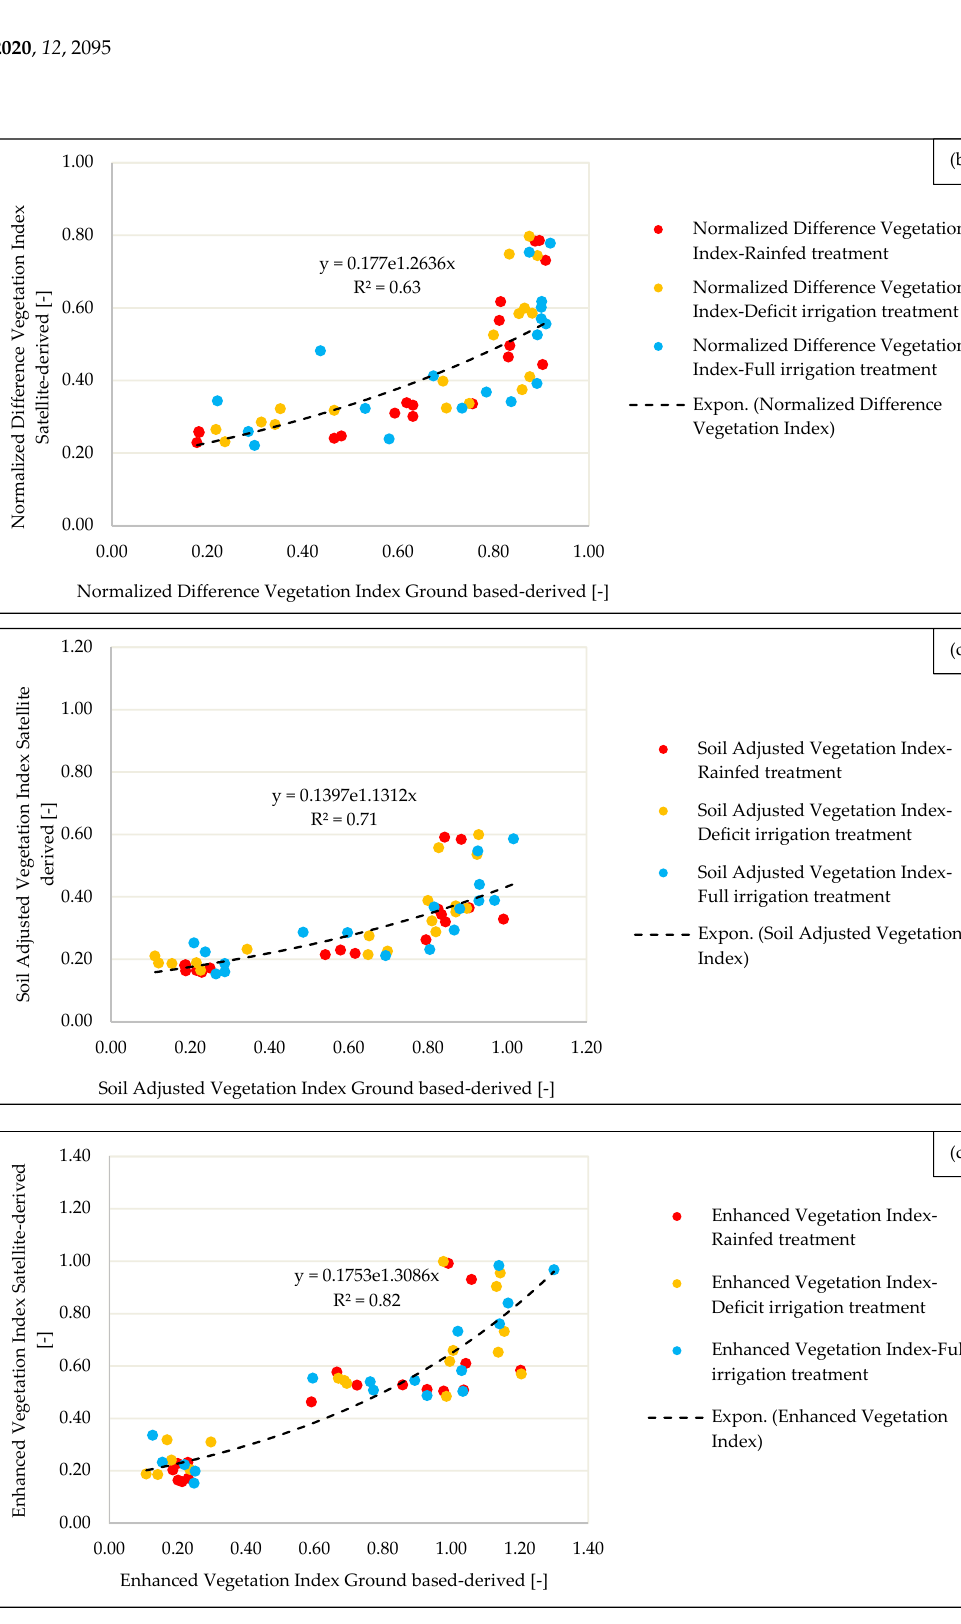
Figure 6. The relationship between satellite (Landsat 8) and ground-based LAI (a) and vegetative indices (NDVI (b), SAVI (c), and EVI (d)).